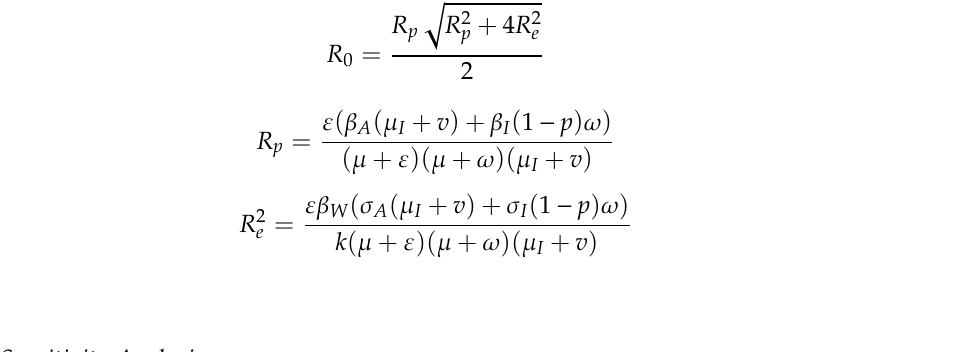
Table 4. Survival parameters: this is a list of parameters that are uniformly modulated and the direction in which they change when survival is increased or decreased. An up arrow ( ↑ ) indicates the parameter is increased by some percent when the equivalent (percent) change in survival is applied. A down arrow ( ↓ ) indicates the parameter is decreased by some percent when the equivalent (percent) change in survival is applied. Symbols Definition Survival Increased SurvivalDecreased Waning virus rate in environment (using the average of k all material values, wood, steal, cardboard, and plastic) Contact rate of person with environment × transmission ↑ β W